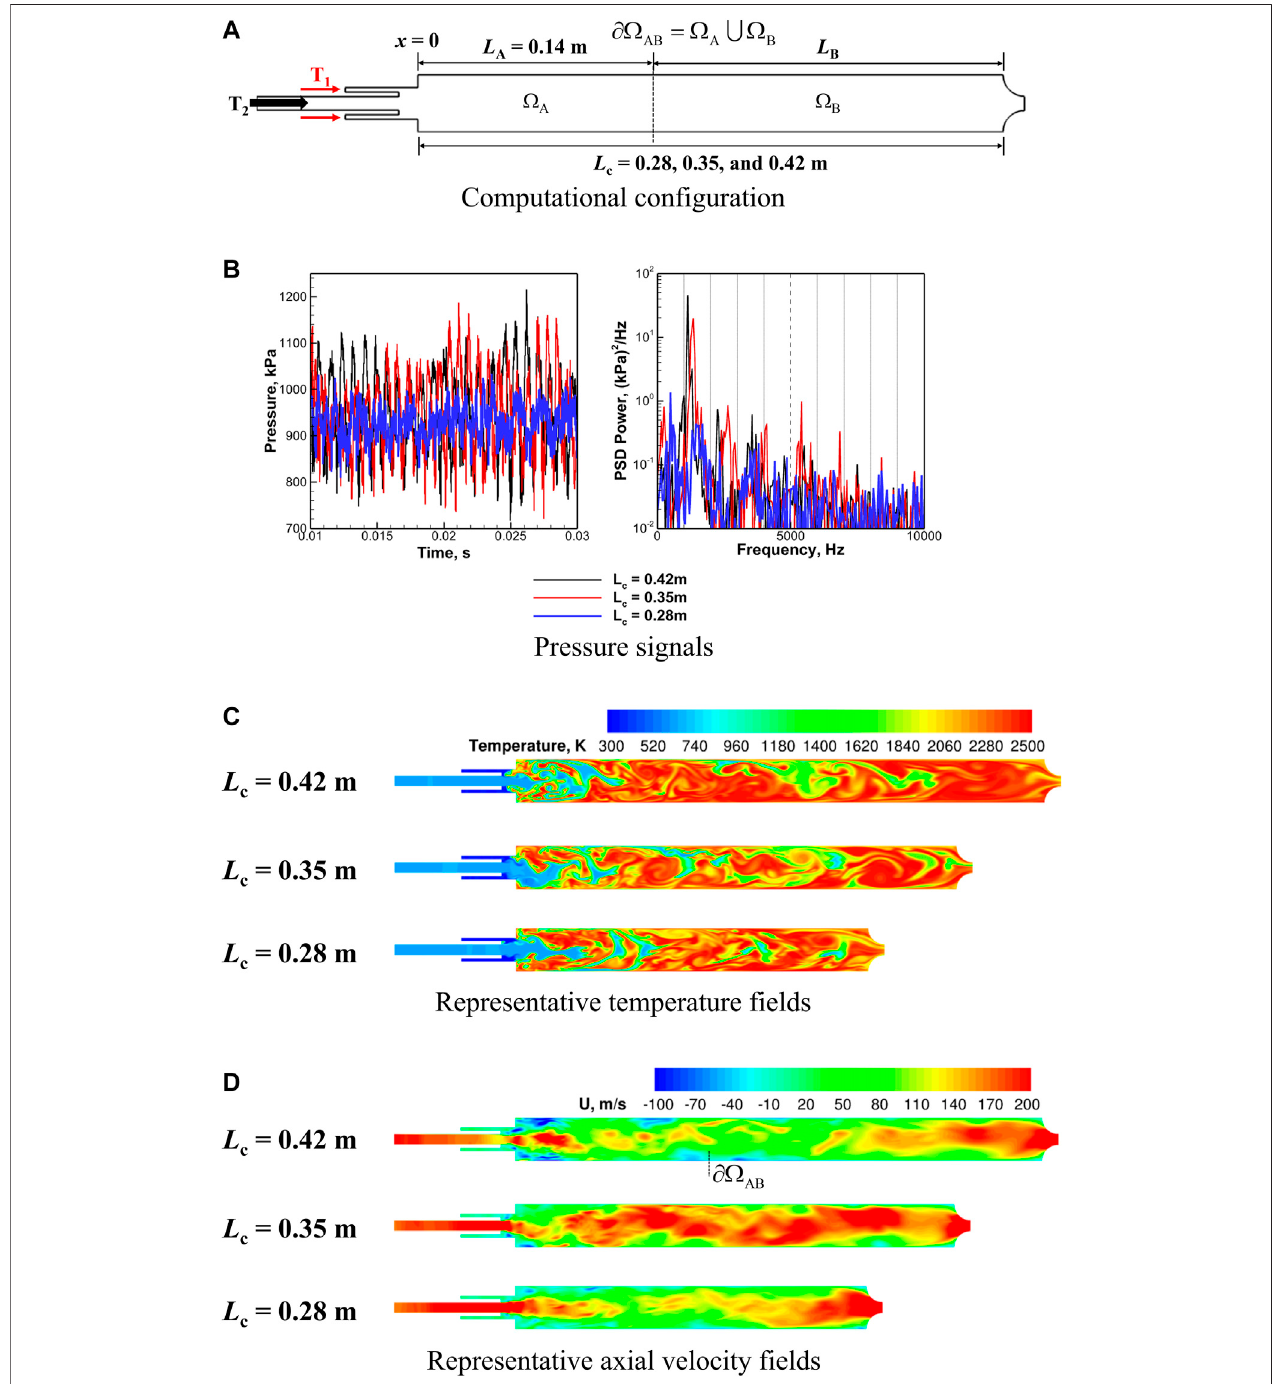
FIGURE 4 | Overview of 2D-planar single-injector model rocket combustor including (A) computational con fi guration and FOM-FOM results with (B) pressure signals measured at x = 0 in (A,C) representative snapshots of the temperature fi elds, and (D) representative snapshots of the axial velocity fi elds.